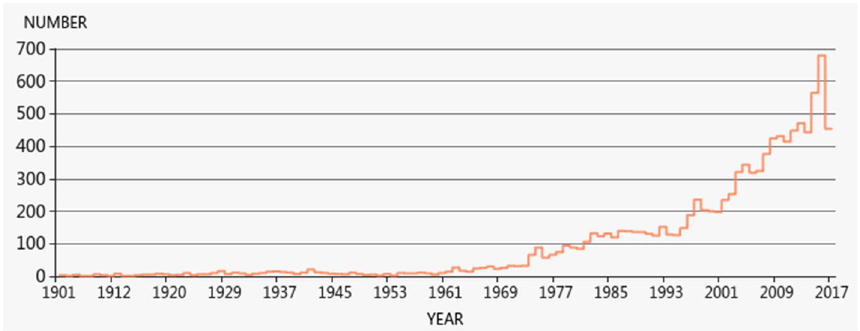
Figure 1. Annual number of selected articles related to work hours.